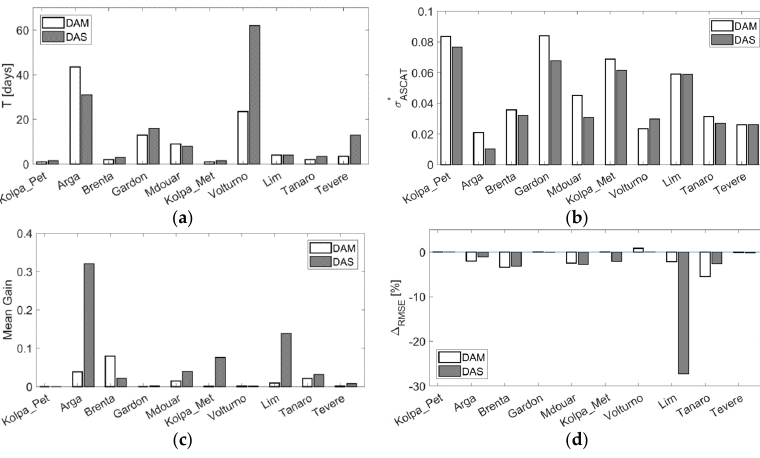
Figure 3. Characteristic time length T ( a ), SWI* ASCAT error standard deviation ( b ), mean Kalman Gain G ( c ), and % improvement in RMSE between simulated and observed stream flow ( d ) obtained during the calibration period within the SM-corr approach by using P 3B42RT (DAS) and P ERA (DAM) for forcing MISDc model.